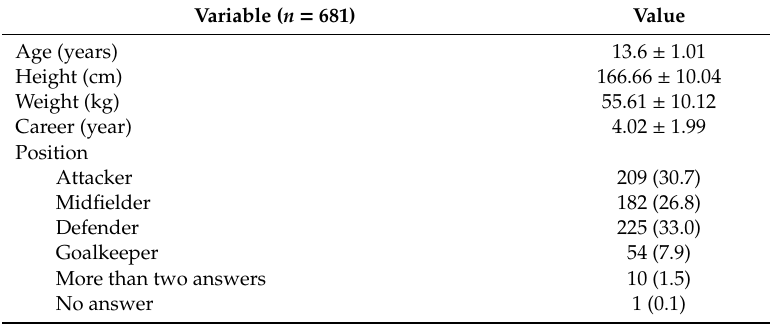
Table 1. Demographic characteristics of U-15 youth soccer players during the 2019